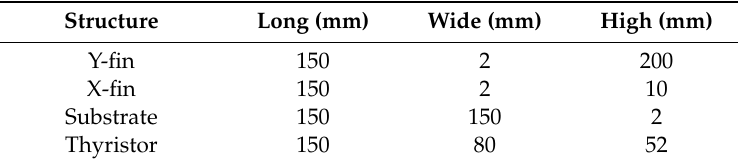
Table 2. The specific parameters of the heat sink.